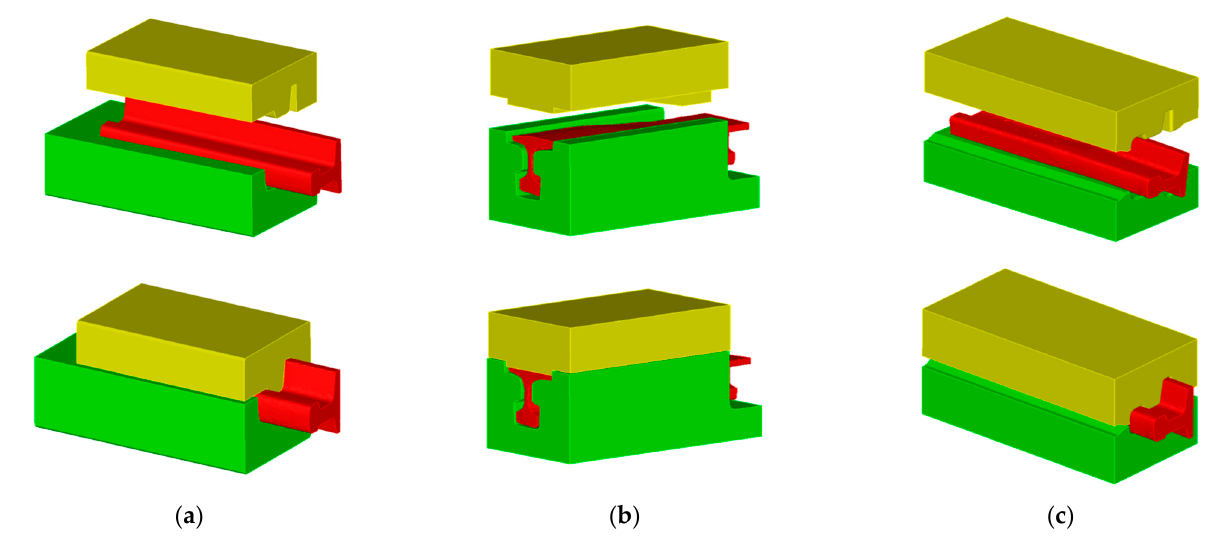
Figure 14. General view of the numerical model before and after: ( a ) operation I of reforging a 60E1A6 rail, ( b ) operation II, ( c ) forging operation III.